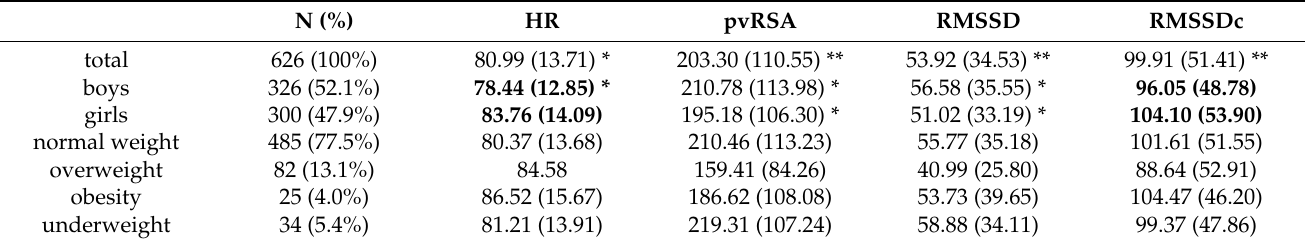
Table 2. HRV metrics in distinct groups in regards to sex and stature. Data presented as mean